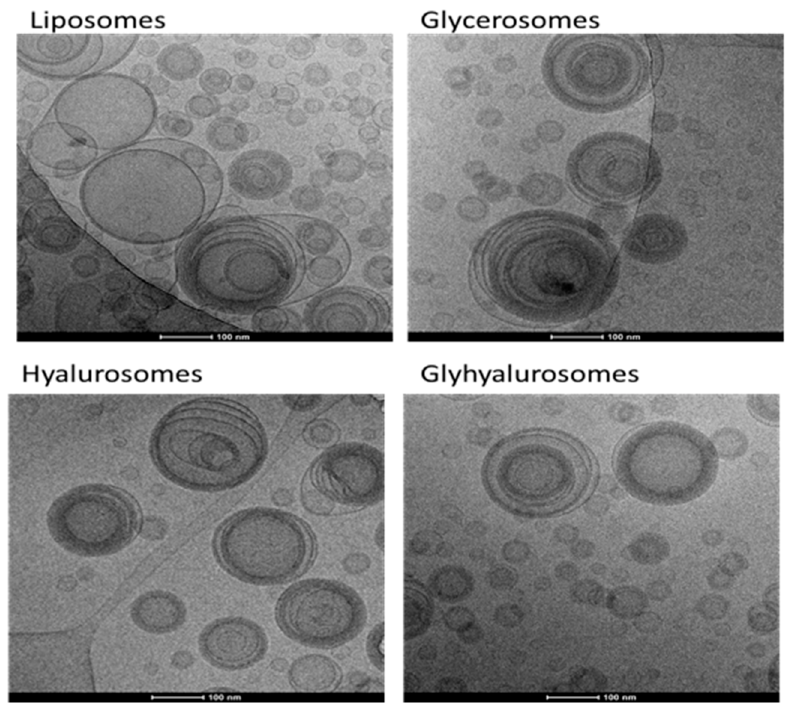
Figure 2. Representative images of liposomes, glycerosomes, hyalurosomes and glyhyalurosomes.